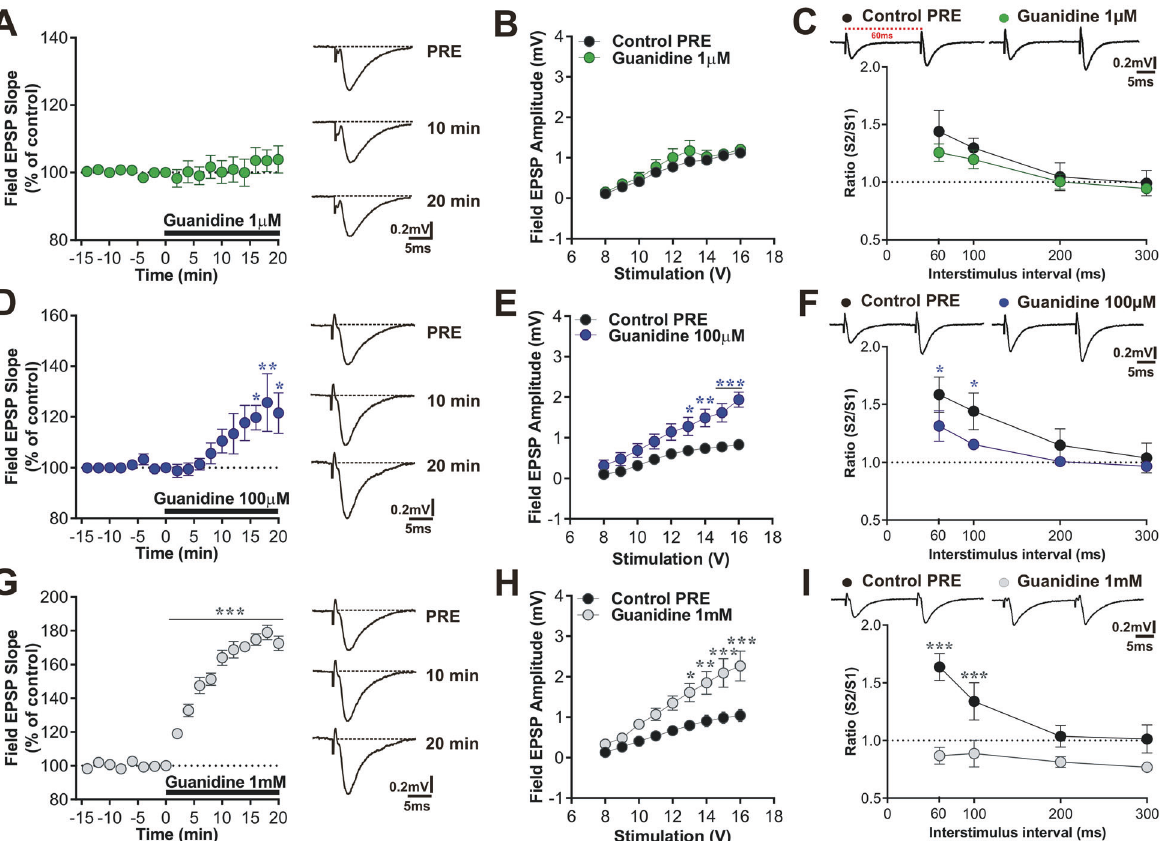
Fig. 2 Guanidine causes a dose-dependent increase of glutamatergic basal transmission. A , D , G Time-course of slope fEPSP recorded from control slices in CA1 region, 10 min before and 20min after bath application of increasing concentrations of Guanidine. Guanidine induces a dose- dependent increase in the fEPSP evoked in CA1 region (two-way ANOVA: Guanidine 100 µM, n = 4, F (9,54) = 4.89, pre vs post 16, 18, and 20min, Bonferroni post hoc * p < 0.05, ** p < 0.01; Guanidine 1 mM, n = 6, F (9,90) = 30.14, pre vs post 1 – 20min, Bonferroni post hoc *** p < 0.001). Next to the graphs, representative traces of fEPSP PRE, 10 and 20 min after Guanidine application. Scale factor is 5 ms/0.2 mV for all traces. B , E , H Input/output (I/O) curves, representing variations in the fEPSP slope in response to the increasing stimulus intensity, show enhanced excitability of the CA1 fEPSPs following Guanidine application (two-way ANOVA time × group interaction: Control PRE vs Guanidine 100 µM, n = 7, F (8,96) = 13.68, 13 – 16V, Bonferroni post hoc * p < 0.05, ** p < 0.01, *** p < 0.001; Control PRE vs Guanidine 1 mM, n = 7, F (8,88) = 3.86, 13 – 16V, Bonferroni post hoc * p < 0.05, ** p < 0.01, *** p < 0.001). C , F , I Upper part; sample traces of paired fEPSPs in response to two sequential presynaptic stimuli at an interval of 60, 100, 200, and 300 ms recorded in CA1 region. Scale bars is 5 ms/0.2 mV for all traces. Graphs represent PPR before and after Guanidine 1 µM, 100 µM, and 1 mM application showing that at the 60 ms and 100 ms interval between pulses, there is a decrease in PPR parameter (two-way ANOVA time × group interaction: Control PRE vs Guanidine 100µM, n = 8, F (3,36) = 1.67, 60ms and 100ms, Bonferroni post hoc * p < 0.05; two-way ANOVA time × group interaction: Control PRE vs Guanidine 1 mM, n = 5, F (3,24) = 20.89, 60 ms and 100ms, Bonferroni post hoc *** p < 0.001). By contrast, the smaller dose of Guanidine (1 µM) did not alter the S2/S1 ratio ( C